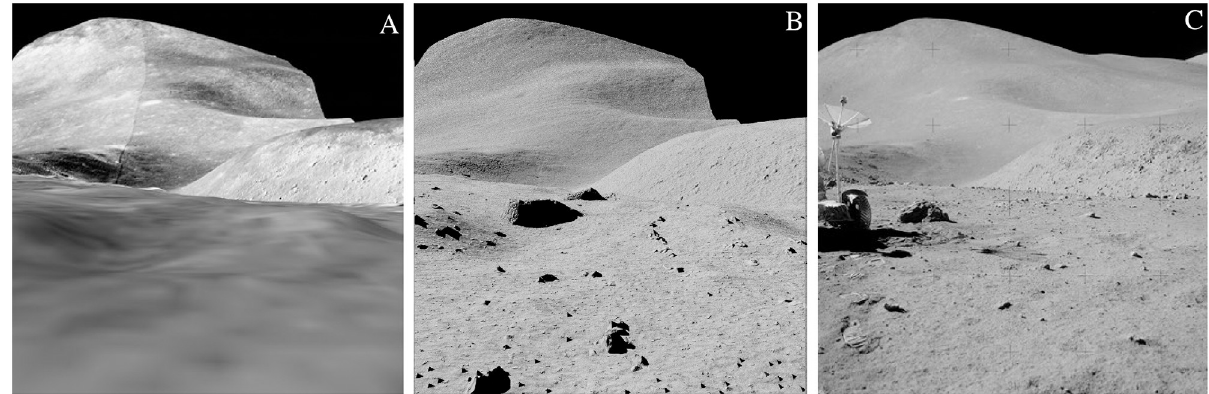
Fig 10. Application of procedural texturing on the scale of a larger airless body. (A) using a digital terrain model and applying orthographic photos as a texture. (B) using a digital terrain model and procedural terrain generation with Blender Cycles on the same digital terrain model. (C) image taken during the Apollo 15 mission from roughly the same